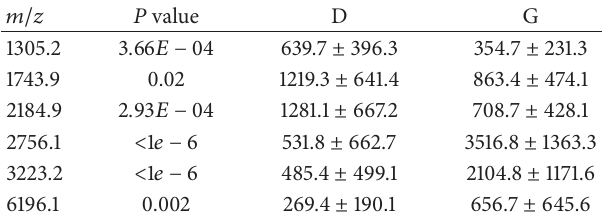
Table 2: The statistics characteristic of the six selected